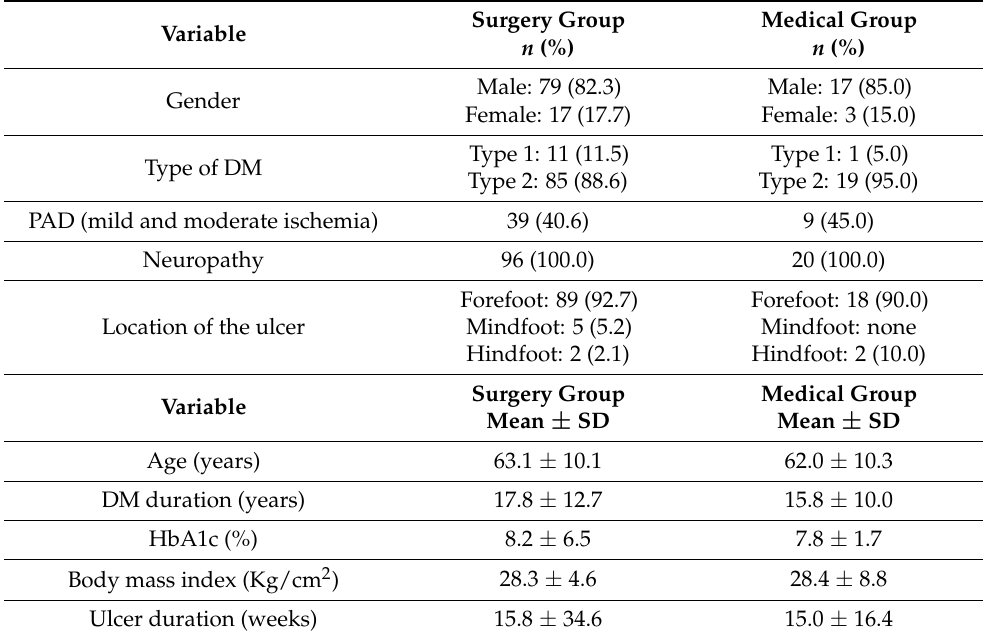
Table 1. Baseline characteristics of the